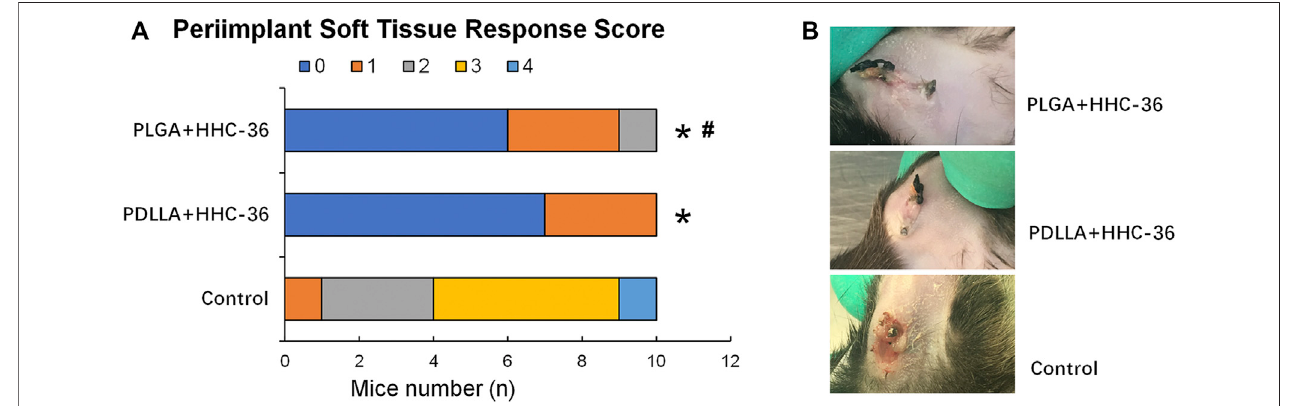
FIGURE 4 | Results of percutaneous implant mice model 2 weeks postoperatively. ( A ) Peri-implant soft tissue response score. ( B ) Comparison of tissue infection around the implants in different groups of mice.